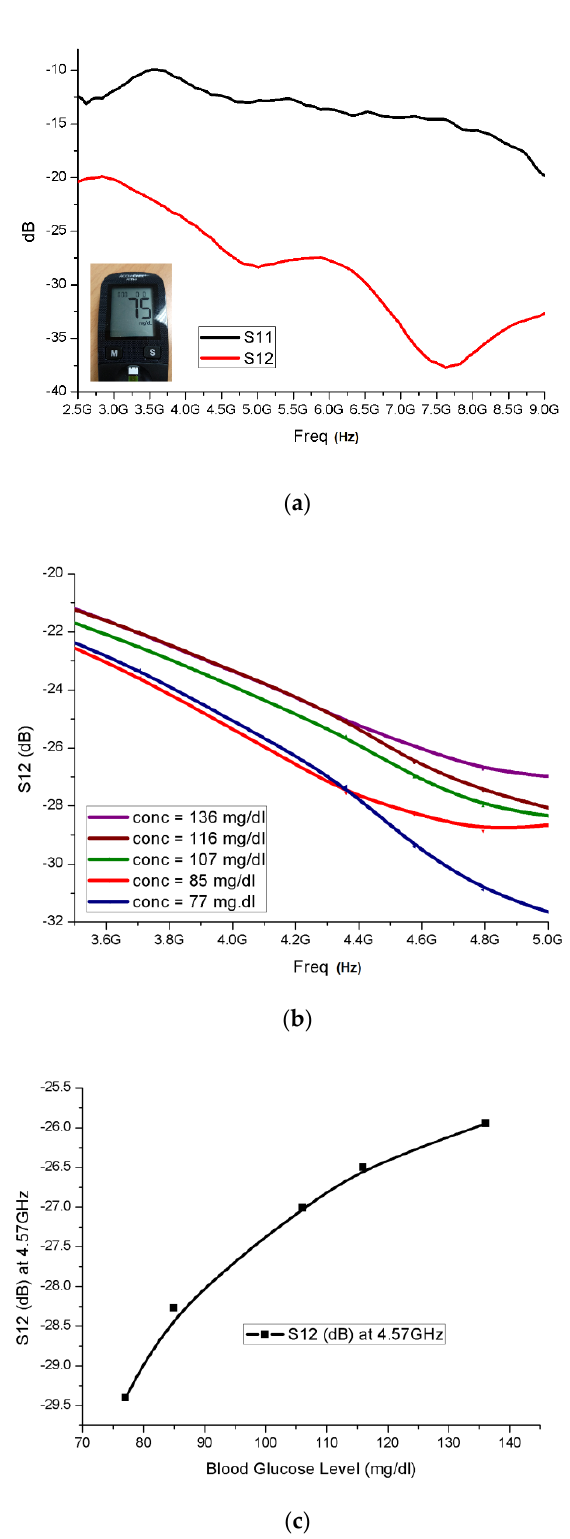
Figure 3. Measured results. ( a ) The measured S11 and S12 parameters against frequency when the blood glucose level was 75 mg/dl; ( b ) the measured S12 parameters as a function of frequency for different blood glucose levels (as denoted as “conc” in the graph). It is important to note that the blood glucose levels in this graph were obtained using the traditional lancing method within 15 m before the measurement of the S-parameters was conducted; ( c ) a graph showing the near-linear relationship between the blood glucose levels and the S12 parameters right at 4.57